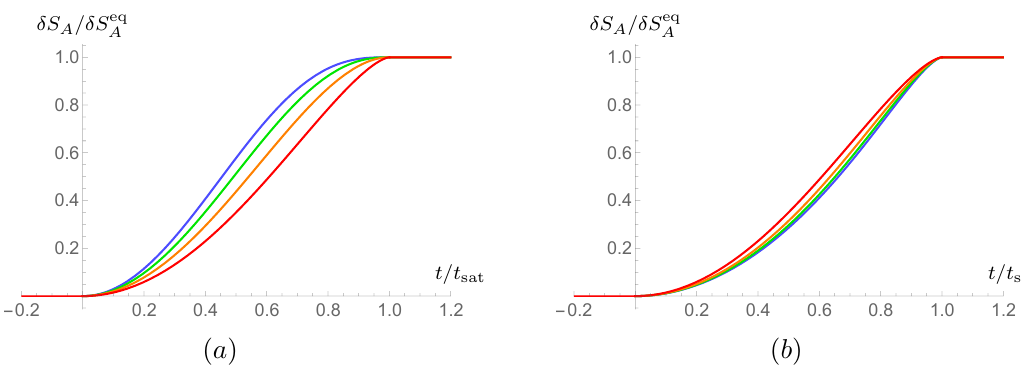
Figure 1 . Evolution of (cid:14)S A ( t ) for the case of the ball ( a ) and the strip ( b ) in d = f 2 ; 3 ; 4 ; 5 g dimensions, depicted in red, orange, green and blue,